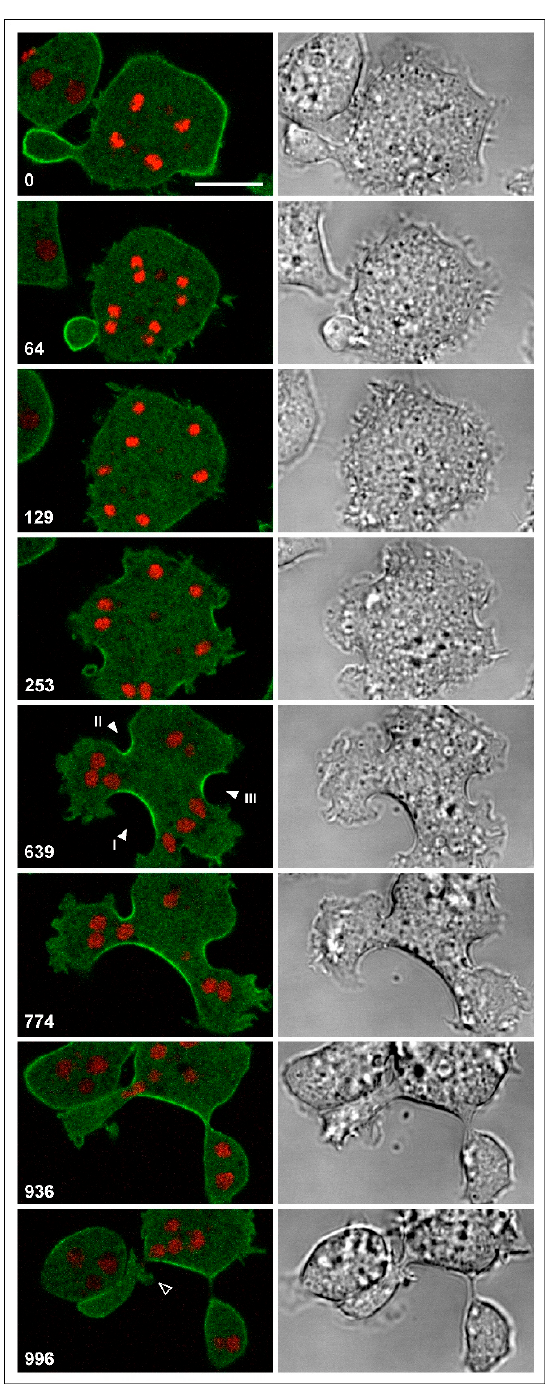
Figure 6. A multinucleate myosin-II-null cell undergoing successful and unavailing cytokinesis. The cell is labeled, like the cell in Figure 5, for cortexillin I (green) and for the chromosomes (red). Three unilateral furrows are indicated by arrowheads in the 639 s frame. Between furrow I and III, abscission of a daughter cell proceeds, whereas between furrows I and II three nuclei slip from the left portion into the major cell body (774 s and 936 s frames). Consequently, the anucleate part is united with the major cell body, forming protrusions toward the latter (open arrowhead in the 996 s frame). Time is indicated in seconds after the first frame. Scale bar, 10 µm. The same sequence is shown in supplementary Video S6.